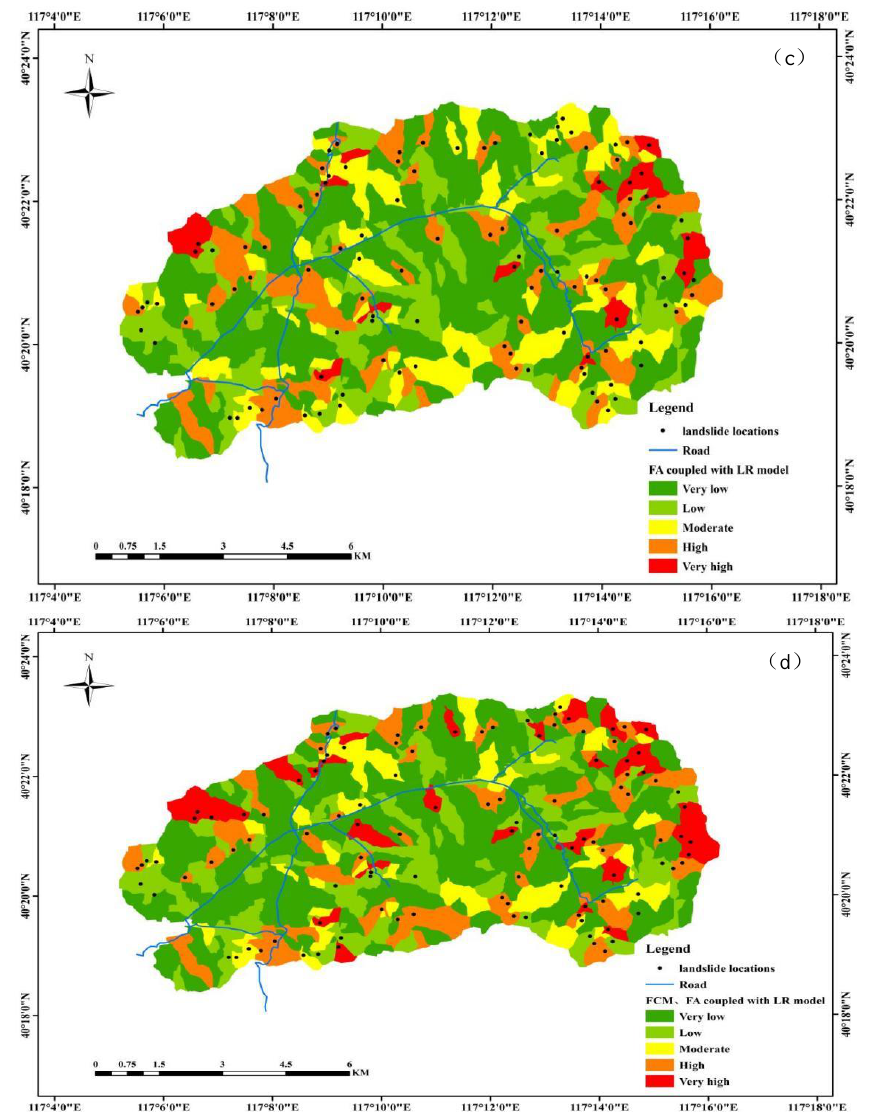
Figure 8. Landslide susceptibility maps: ( a ) LR model; ( b ) FCM coupled with LR model; ( c ) FA coupled with LR model; ( d ) FCM, FA coupled with LR model.